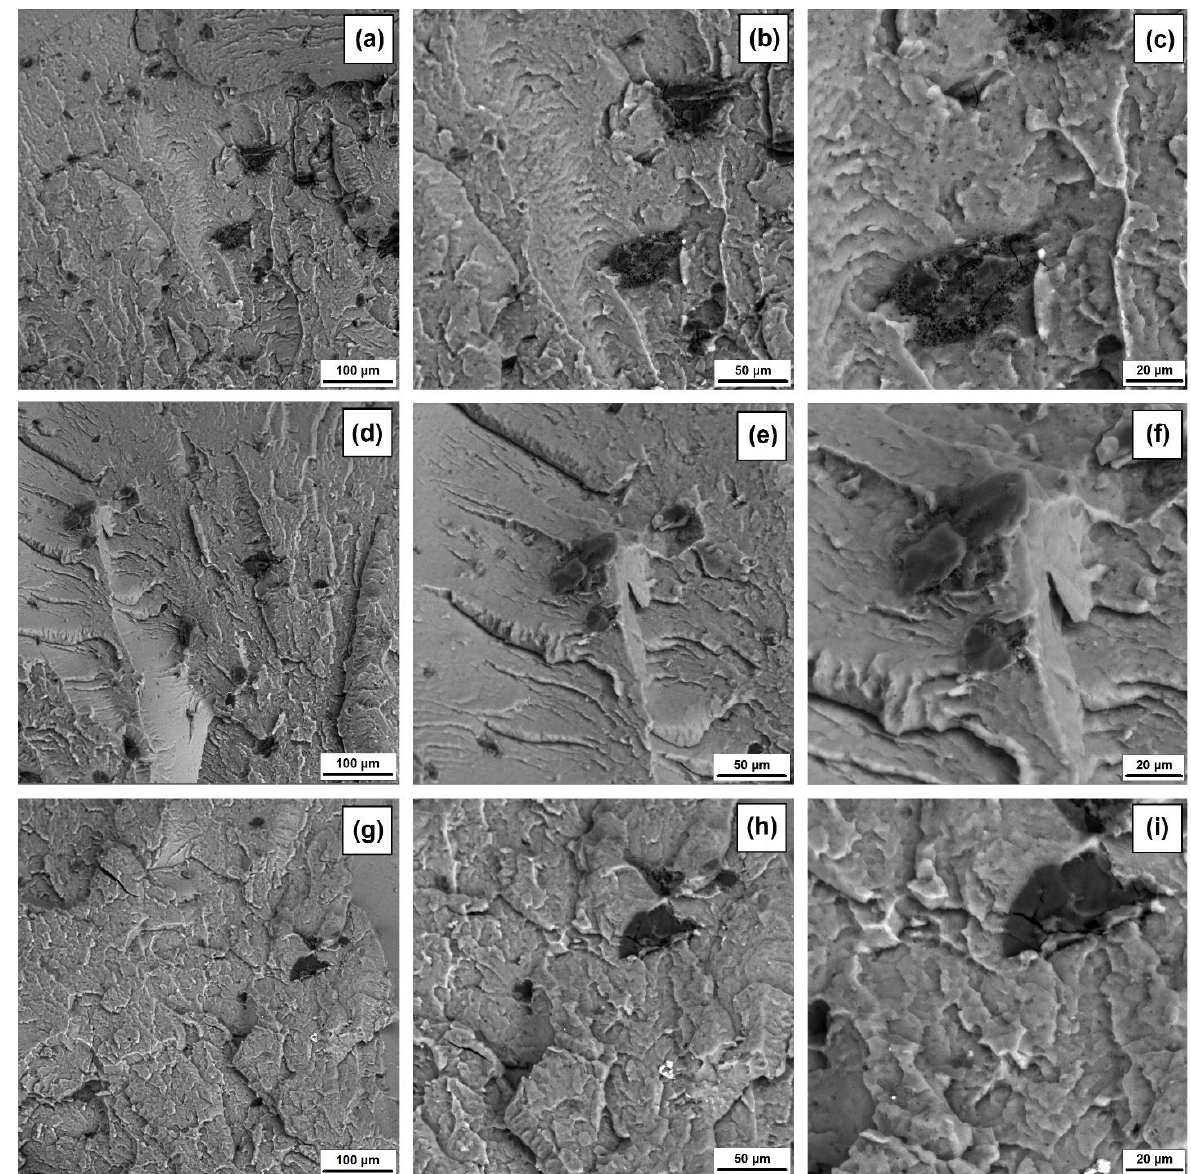
Figure 10. SEM images for PVC with 5 wt% of halloysite – lignin hybrid materials with the following component proportions: 1:5 wt/wt ( a – c ), 1:1 wt/wt ( d – f ) and 5:1 wt/wt ( g – i ).